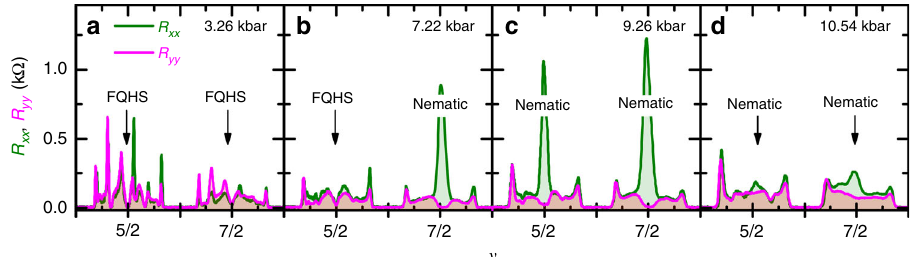
Fig. 2 Pressure dependence of magnetoresistance in the second Landau level. R xx and R yy are shown for sample A, as measured along two mutually perpendicular crystal axes of GaAs. Pressures are 3.26, 7.22, 9.26, and 10.54 kbar for a – d , respectively. The temperature is T ≈ 12 mK. Traces allow us to observe the evolution of ground states at half- fi lled Landau levels ν = 5/2 and 7/2. The nature of the ground state at these two fi lling factors is marked by text; FQHS stands for fractional quantum Hall state